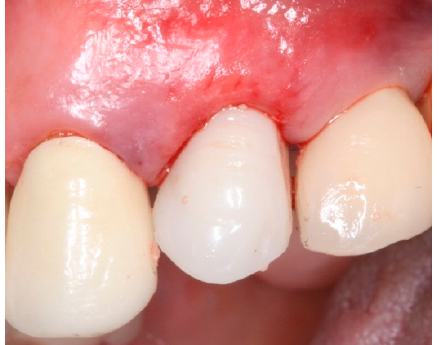
Figure 8. Interim prosthesis (screw retained restoration) on immediate implant placed on #24.